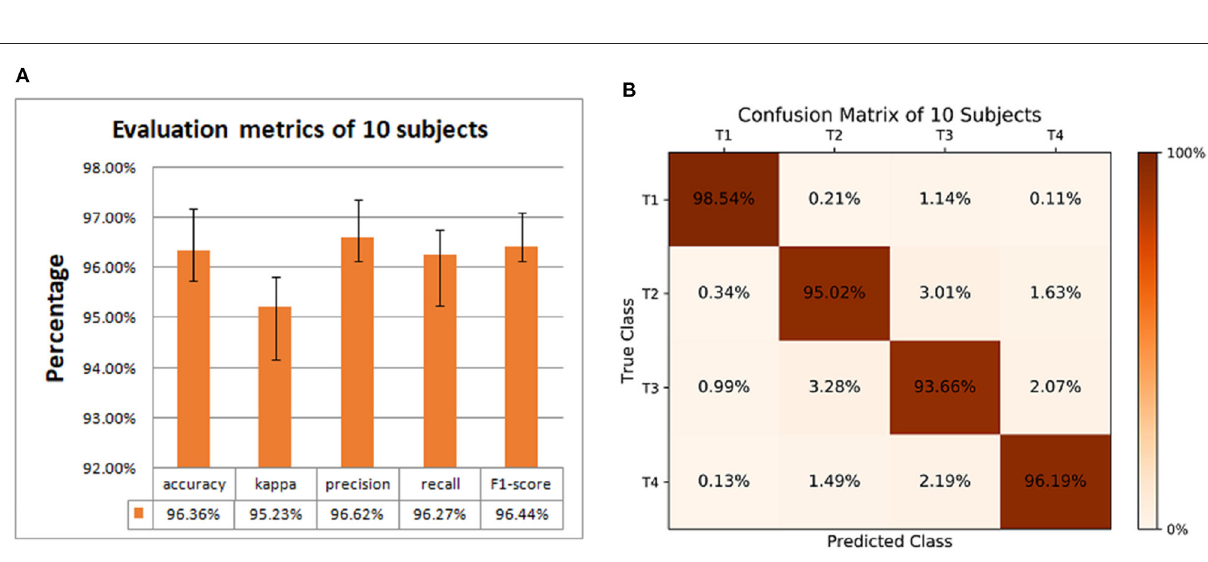
FIGURE 4 | Classification performance of 10 subjects. (A) Evaluation metrics. (B) Confusion matrix for the accuracy of 4 motor imagery (MI)